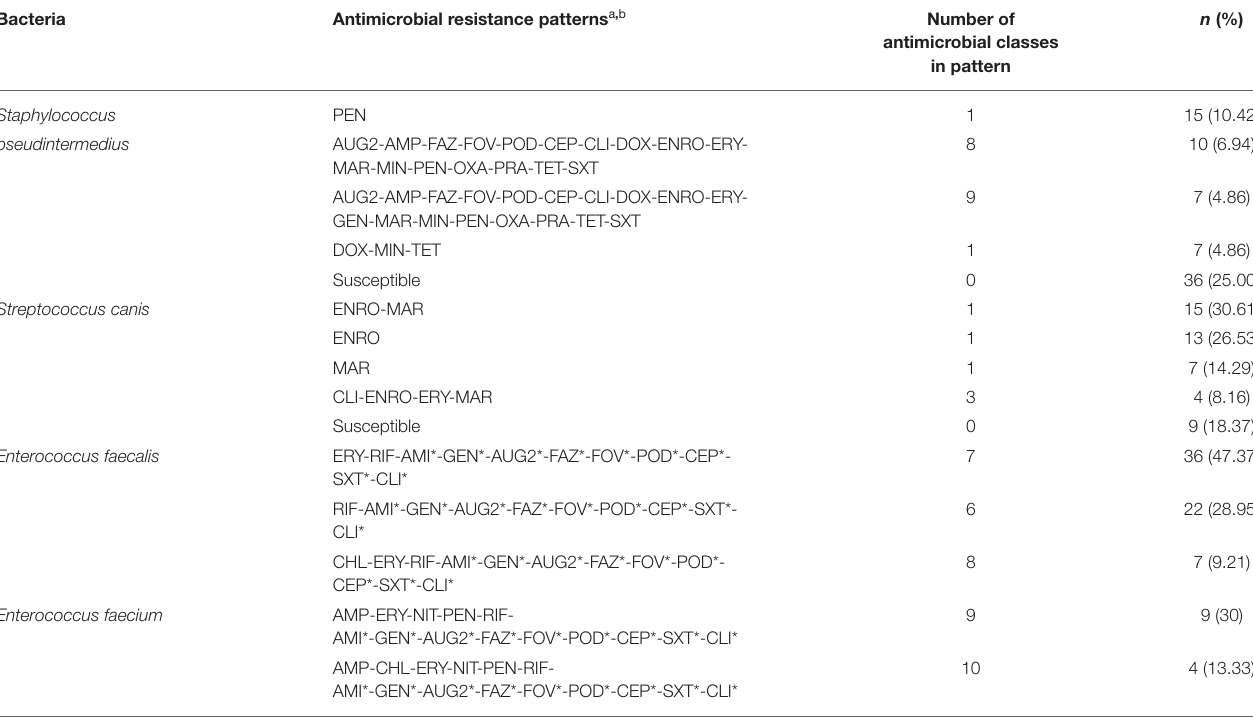
TABLE 3 | The most common antimicrobial resistance patterns in Gram-positive bacteria isolated from canine urine samples. Bacteria Antimicrobial resistance patterns a , b Number of